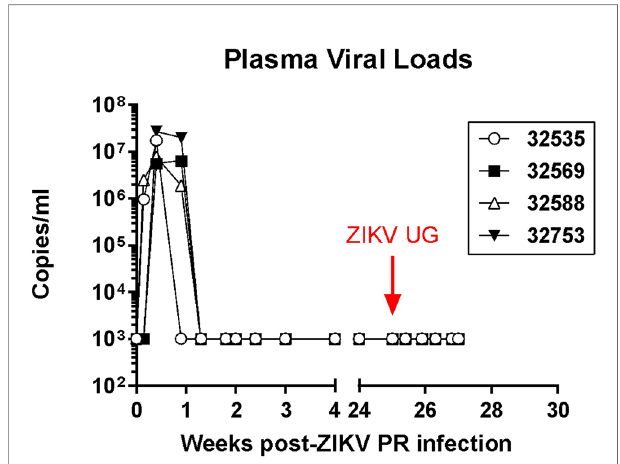
FIGURE 1 | Plasma ZIKV loads in four olive baboons. The baboons were initially infected with the Puerto Rico strain of ZIKV (PRVABC59, 2015) via subcutaneous injection with the virus in either a high dose of 10 6 TCID 50 ( n = 2, open symbols) or a low dose of 10 4 TCID 50 ( n = 2, closed symbols). After 25 weeks, the baboons were exposed to 10 4 TCID 50 of the divergent ZIKV Uganda strain (ZIKV UG1947) through subcutaneous